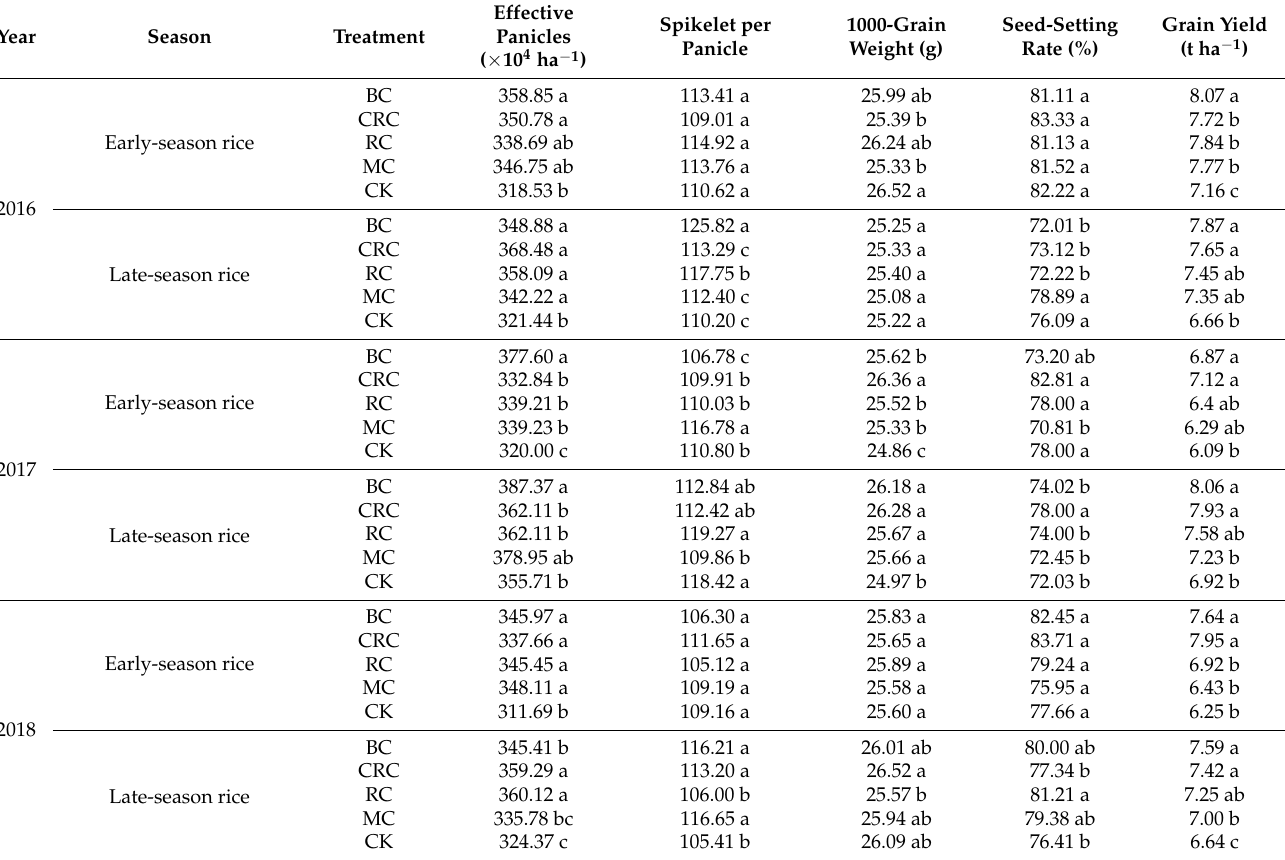
Table 2. Grain yields under different organic material treatments in